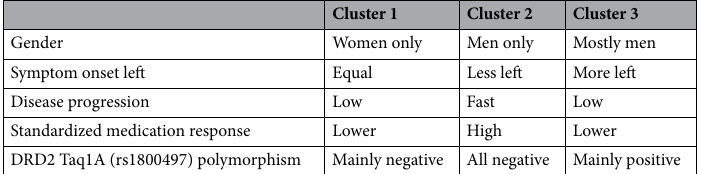
Table 2. Significant cluster characteristics. Overview of significant cluster